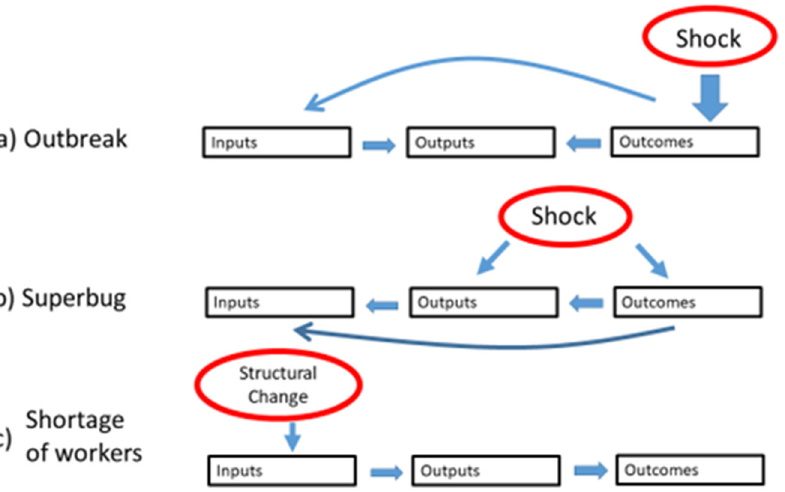
Figure 2. Hypothetical responses of a health system to example shocks or structural changes labelled ( a ), ( b ), and ( c ). Source: Expert Panel Opinion [10].